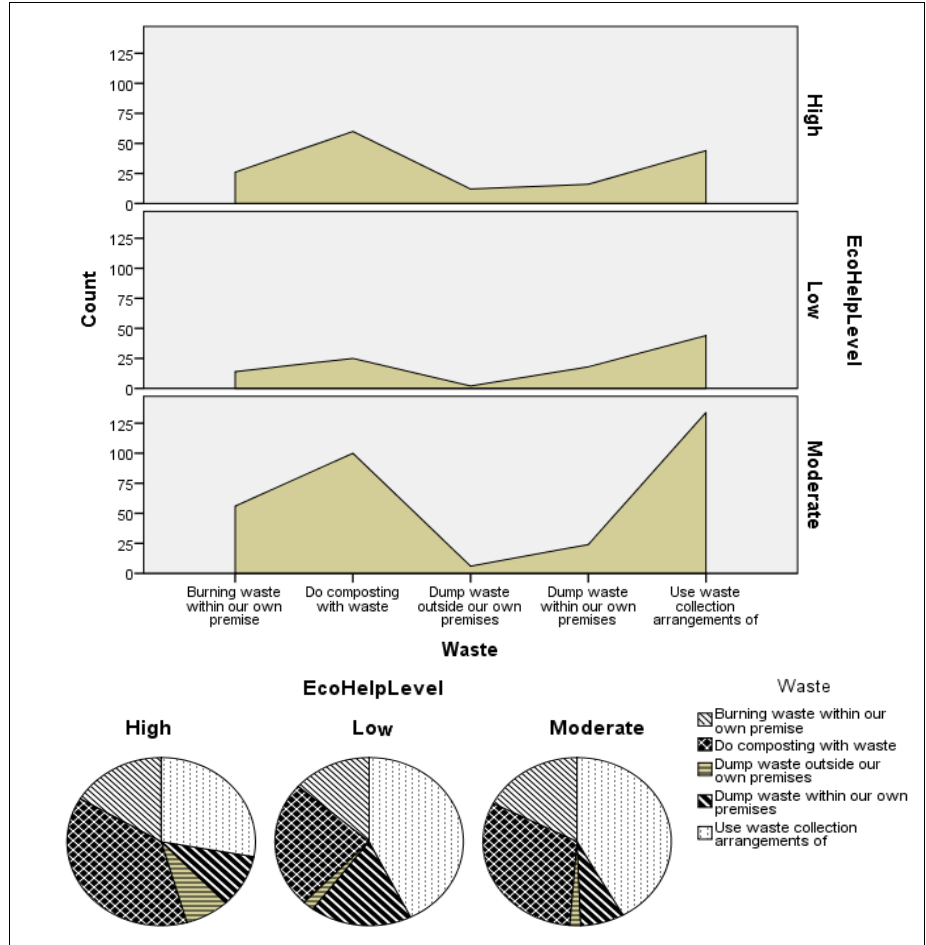
Figure 03: Eco-helping levels and Waste disposal